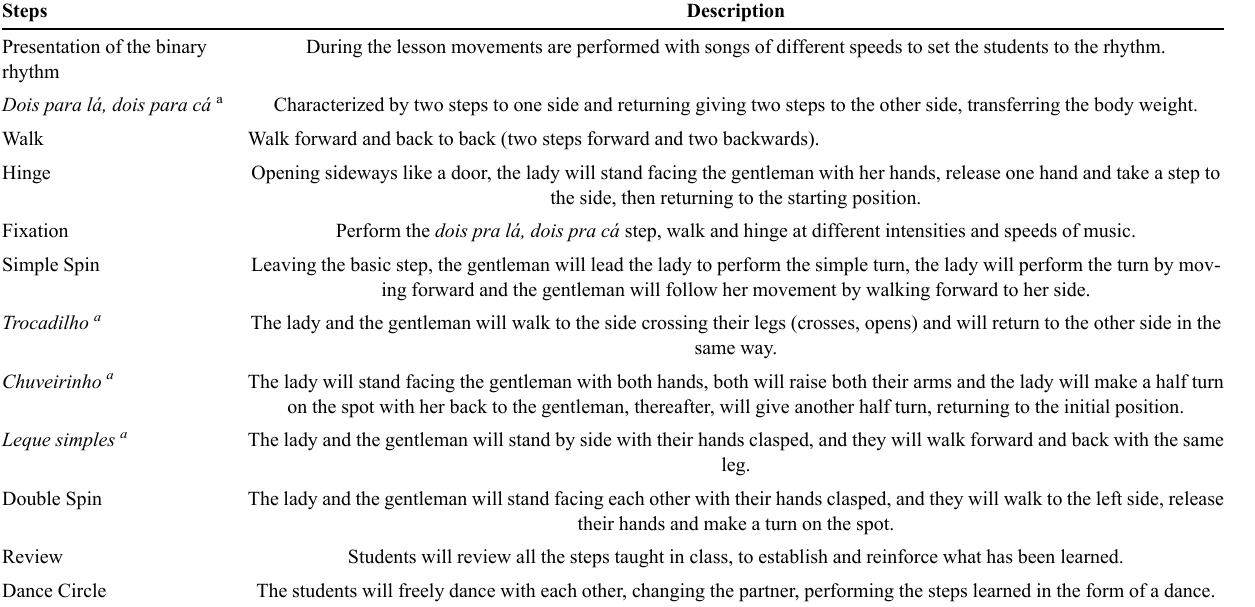
Table 1 - Description of the steps to be taught in the Binary rhythm